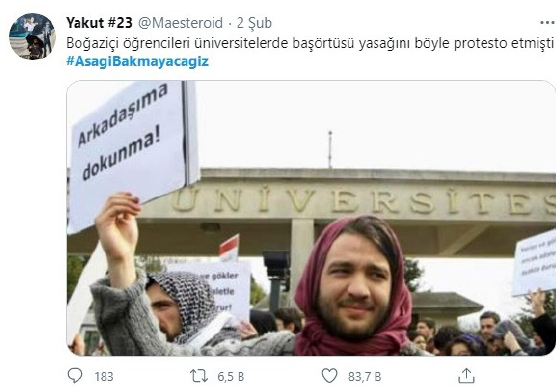
Figure 5. Boğaziçi students protested the headscarf ban in universities. Source: Yakut #23